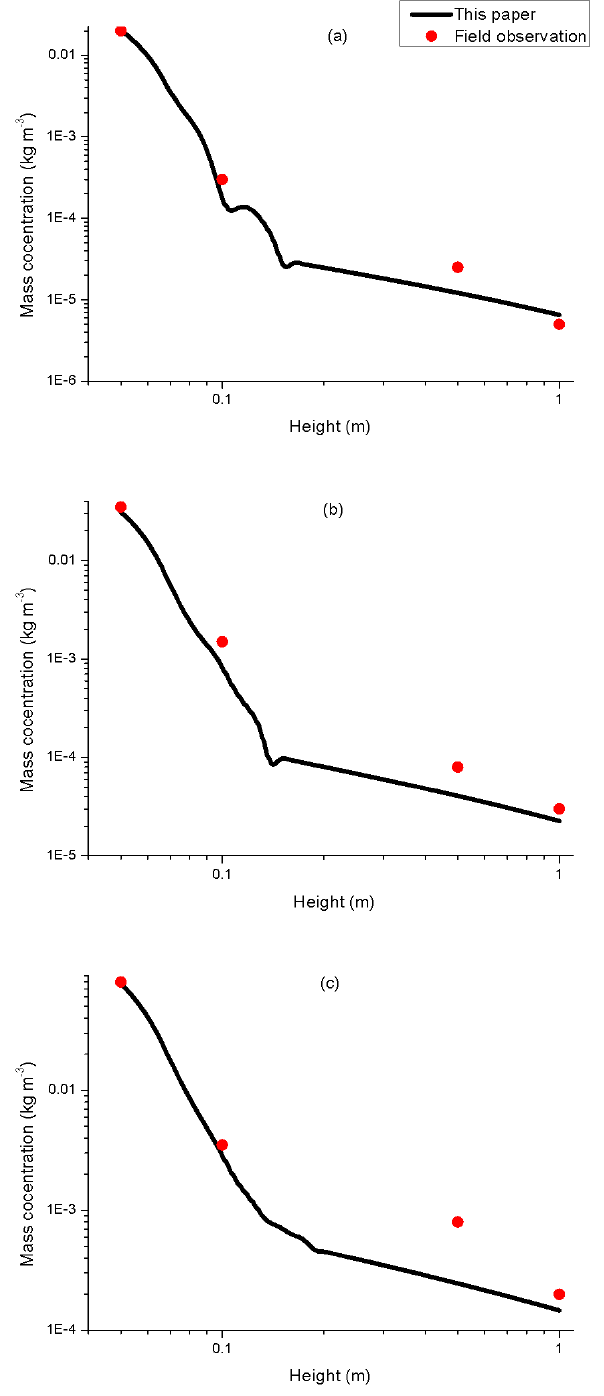
Figure 2. Comparison of mass concentration for this paper and field observation (a) u ∗ = 0 . 35ms − 1 ; T = 268 . 65K; (b) u ∗ = 0 . 41ms − 1 ; T = 268 . 65K; (c) u ∗ = 0 . 54ms − 1 ; T = 268 . 65K). The results of red dot are from near Saskatoon, Canada in 26 Jan- uary